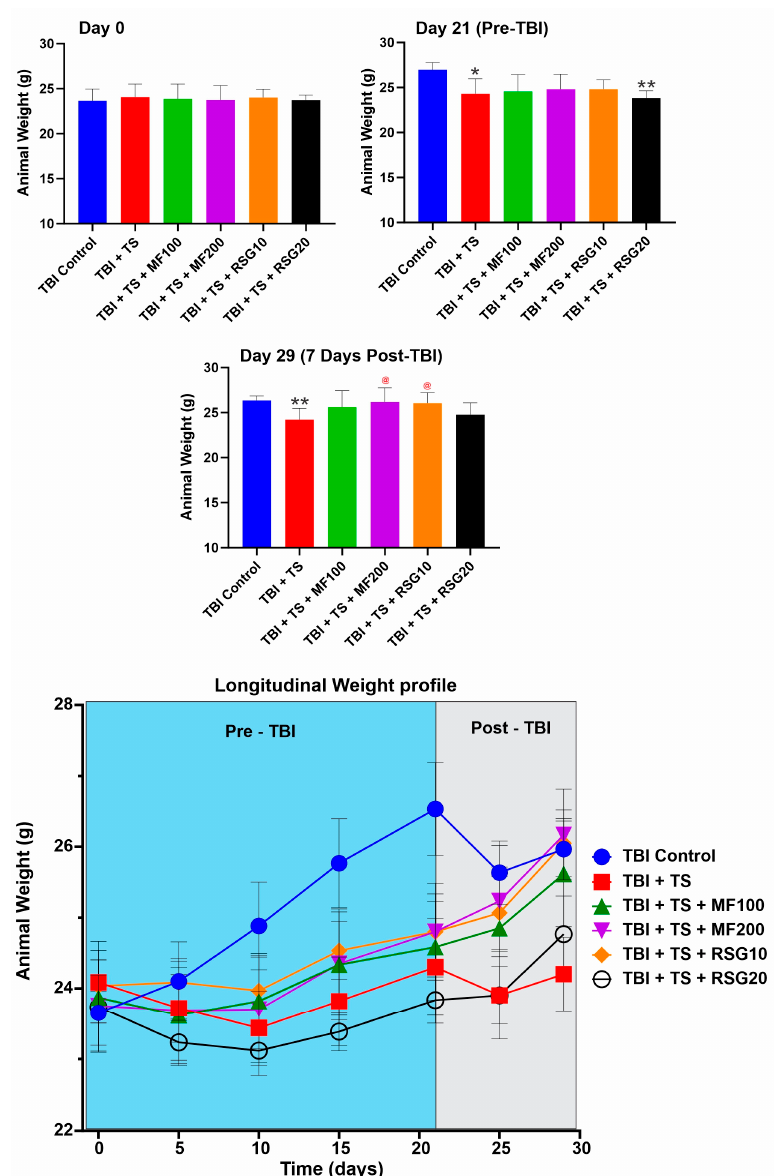
Figure 1. Effect of MF and RSG treatments on body weight of TS-exposed and TBI-induced mice. Measurements of animals’ body weight did not significantly differ between the tested groups at Day 0. However, at the end of the three weeks of exposure before TBI, animals exposed to TS showed decreased body weight compared to the control. Post-TBI body weight recovered following MF and RSG treatments for TBI. n = 6 biological replicates, * p < 0.05, ** p < 0.01 versus control. @ p < 0.05, non-treated versus MF/RSG-treated